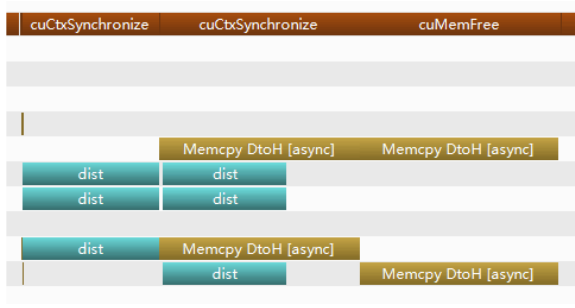
Fig. 7. The profile of stream scheduling on calculating the distance matrices.